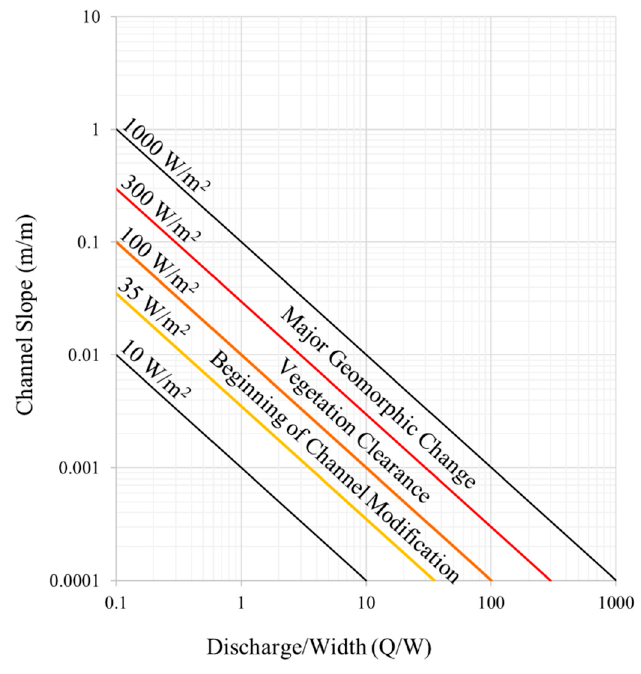
Figure 2. Stream power screening tool with threshold power lines for assessing degradation and aggradation potential of streams.